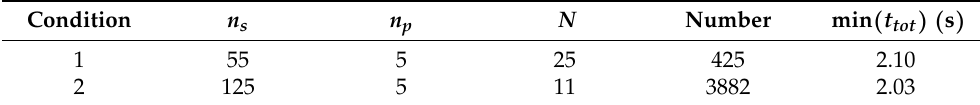
Table 5. Two battery pack structures in the solutions.